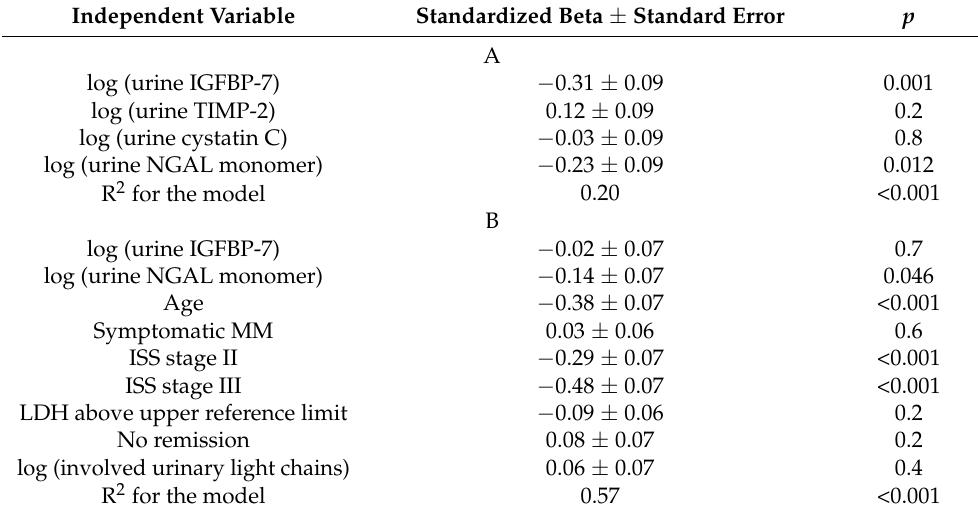
Table 4. Multiple linear model showing which of the studied urinary markers of tubular injury predicts eGFR in the studied group of MM patients ( n = 124): A. independently of each other; B. independently of clinically relevant